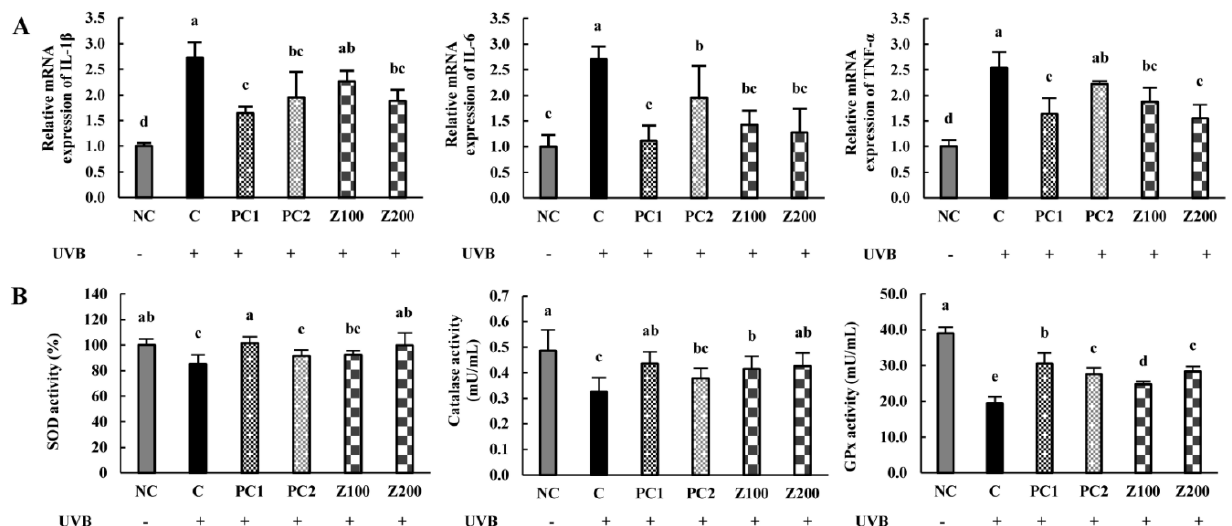
Figure 5. Effects of FSH-ZM on pro-inflammatory cytokine levels and antioxidant activity in skin from the back of UVB- irradiated HRM-2 hairless mice. ( A ) mRNA expressions (IL-1 β , IL-6, TNF- α ). ( B ) ELISA (SOD, catalase, GPx). NC, normal control; C, UVB-irradiated control; PC1, positive control 1, L-ascorbic acid 200 mg/kg b.w.; PC2, positive control 2, Arbutin 200mg/kg b.w.; Z100, FSH-ZM 100 mg/kg b.w.; Z200, FSH-ZM 200 mg/kg b.w. Values are presented as mean ± standard deviation (n = 6), and different superscript letters indicate significance at p < 0.05.